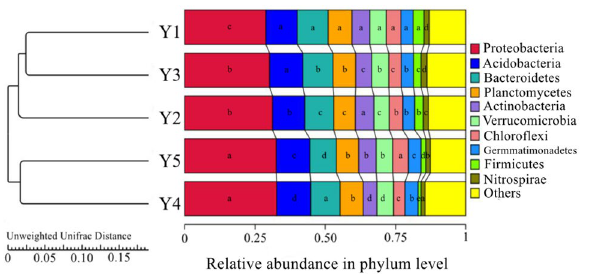
Figure 2. UPGMA dendrogram and relative abundance of main bacterial phyla across sampling over years. Different lower-case letters indicate significant differences ( p < 0.05) among the six treatments, the same as